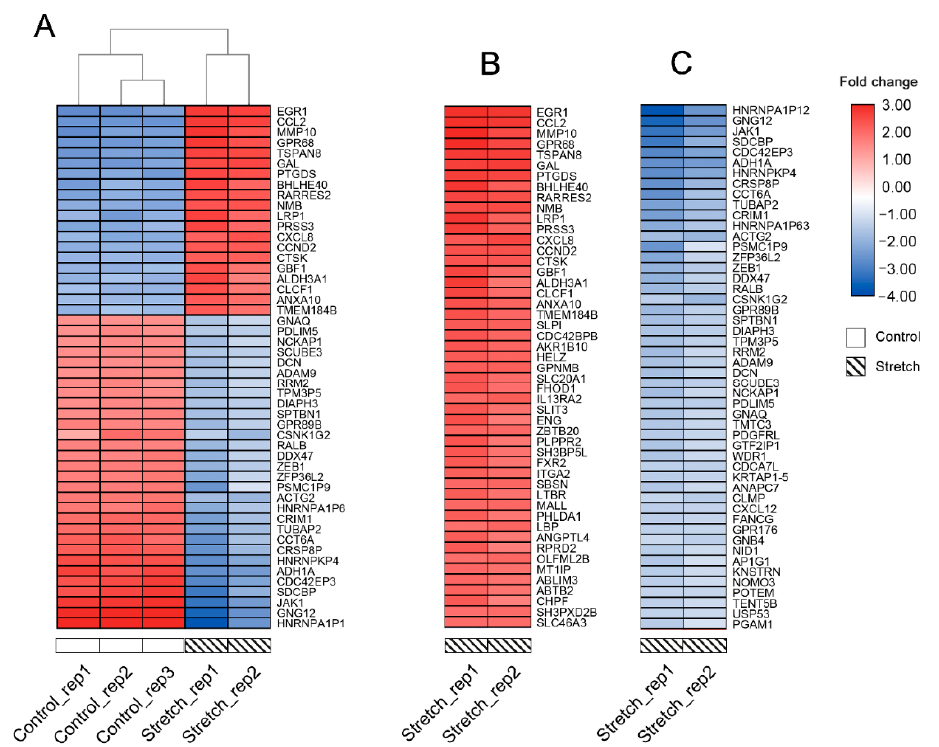
Figure 3. ( A ) Cluster heatmap demonstrates top 50 DEGs with the greatest absolute fold change, and hierarchical clustering analysis results according to groups. Each row represents a DEG, and each column represents a sample; ( B ) top 50 upregulated DEGs of distraction group; ( C ) top 50 downregulated DEGs of distraction group. The colour displays the fold change. Red indicates upregulation in gene expression, and blue indicates downregulation. The darker in colour, the greater fold change.